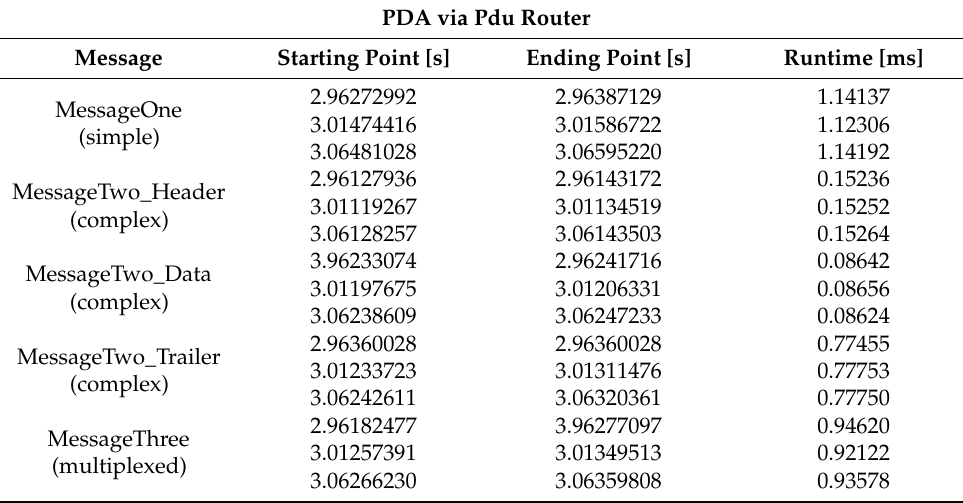
Table 3. Runtime measurements results for PDA via Pdu